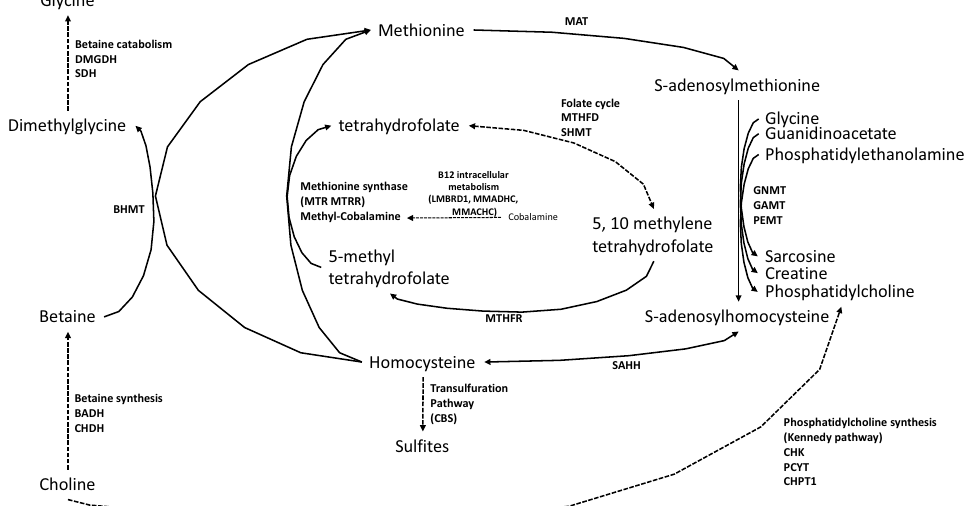
Figure 1. Schematic representation of 1C metabolism. BADH betaine aldehyde dehydrogenase, BHMT betaine- homocysteine methyltransferase, CBS cystathionine beta-synthase, CHDH choline dehydrogenase, CHK choline kinase, CHPT1 choline phosphotransferase, DMGDH dimethylglycine dehydrogenase, GAMT guanidinoacetate methyltransferase, GNMT glycine N-methyltransferase, MAT methionine adenosyltransferase, MTHFD methylenetetrahydrofolate dehydrogenase, MTR methionine synthase, MTRR methionine synthase reductase, PCYT CTP-phosphocholine cytidyltransferase, SAHH S-adenosylhomocysteine hydrolase, SDH sarcosine dehydrogenase, SHMT serine